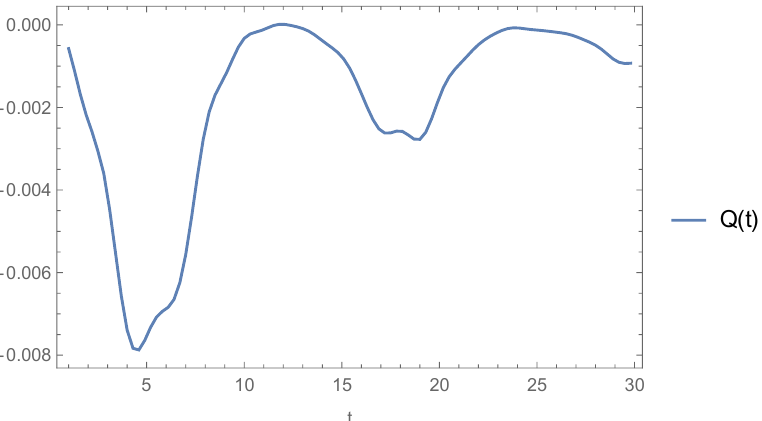
Figure 3. Time evolution of the symmetry associated number Q during the relaxation of extra space